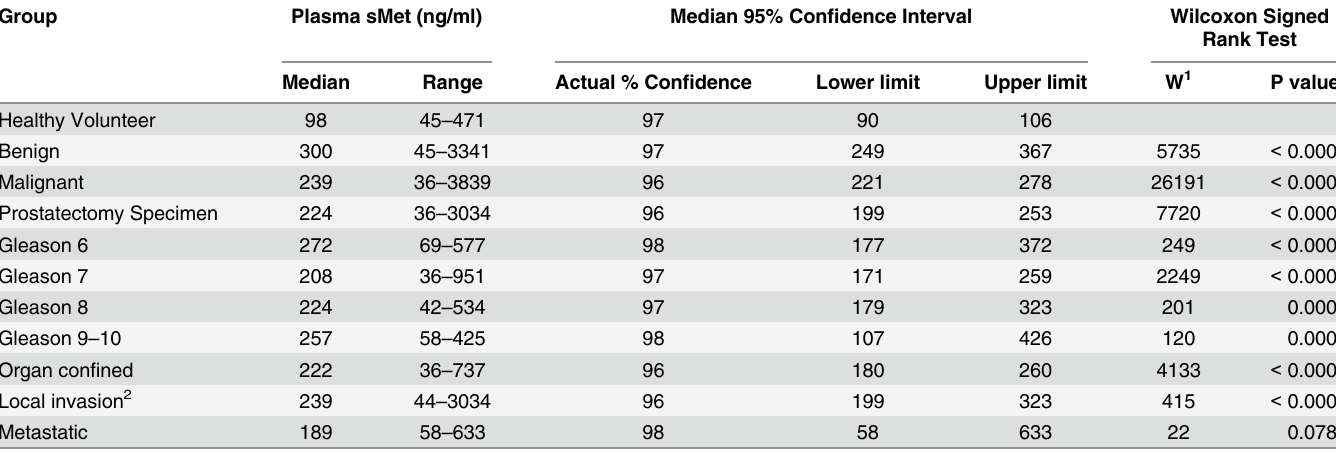
Table 2. Group plasma sMet medians, ranges, 95% confidence intervals and comparison to normals (shaded) by Wilcoxon Signed Rank Test.